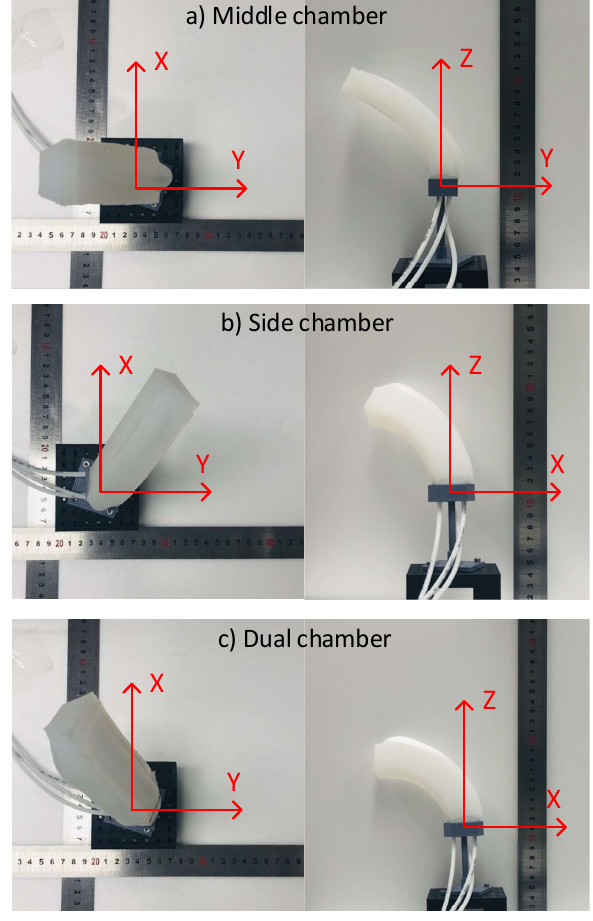
Figure 7. Top and side view of inflations, which include: ( a ) Middle chamber’s inflation, ( b ) side chamber’s inflation, and ( c ) dual-chamber inflation.